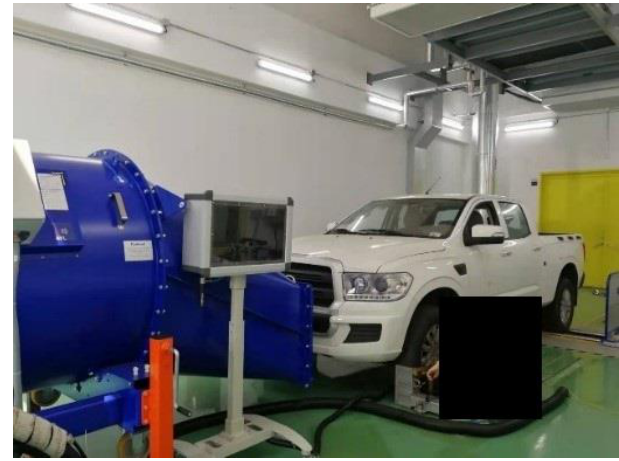
Figure 9. Revolving drum test bench.